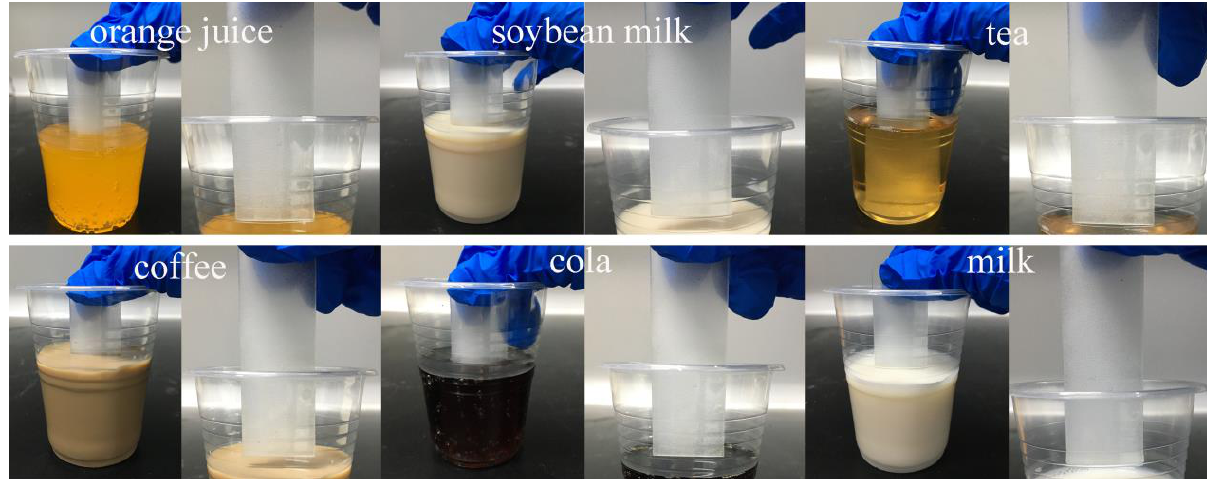
Figure 11. Repellent properties of the FEP-S coatings for common liquids.